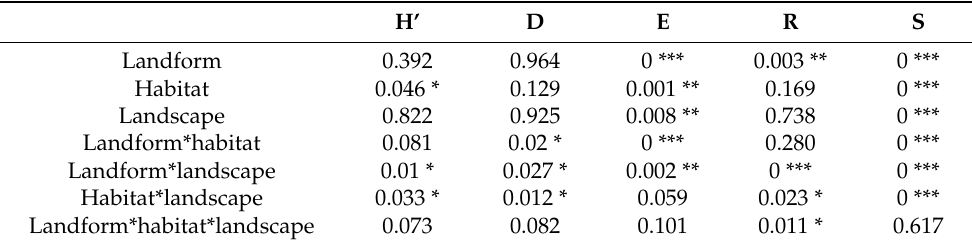
Table 6. Multivariate analysis of variance of the effects of different scales (landform, habitat, land- scape) on soil